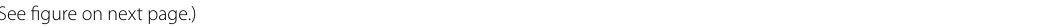
figure on next Fig. 1 Locations of study area (open square) in the Great Lakes region of North America ( A ) and Nissouri Creek subwatershed (closed circle) in the agriculturally dominated landscape of southwestern Ontario ( B ), where the majority of agricultural lands have tile drainage (red shading). Panel C shows the studied headwater branch of Nissouri Creek located in a woodlot with stream sampling sites distributed along two first order segments draining a spring-fed marsh (western branch, grey triangles) and a tile drained field (northern branch, orange triangles), as well as the downstream combined segment (magenta triangles). Blue arrows on stream lines indicate direction of